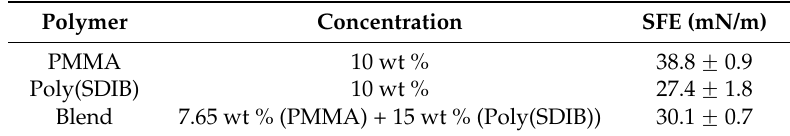
Table 2. Determined surface free energy (SFE) of the used polymers and the blend.